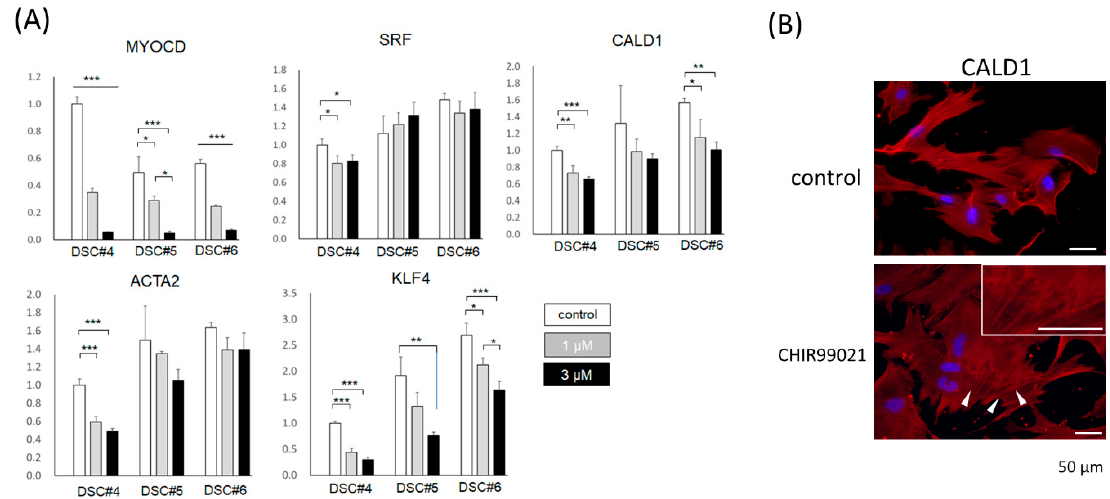
Figure 4. CHIR99021 treatment suppresses the expression of smooth muscle–related genes in DSC cells. ( A ) Relative expression levels of MYOCD, SRF, CALD1, ACTA2, and KLF4 in three DSC cell lines (DSC#4–#6) treated with the control and 1 or 3 µM CHIR99021 ( n = 3). Expression levels were normalized to GAPDH, and the results are expressed as the mean ± S.D. Tukey–Kramer test, * p < 0.05, ** p < 0.01, *** p < 0.001. ( B ) Immunostaining of DSC cells treated with control or CHIR99021(+) medium for CALD1 (red). Blue; Hoechst 33,342 nuclear staining. Arrowheads: stress fibers associated with CALD1 (red). Bars = 50 µm.